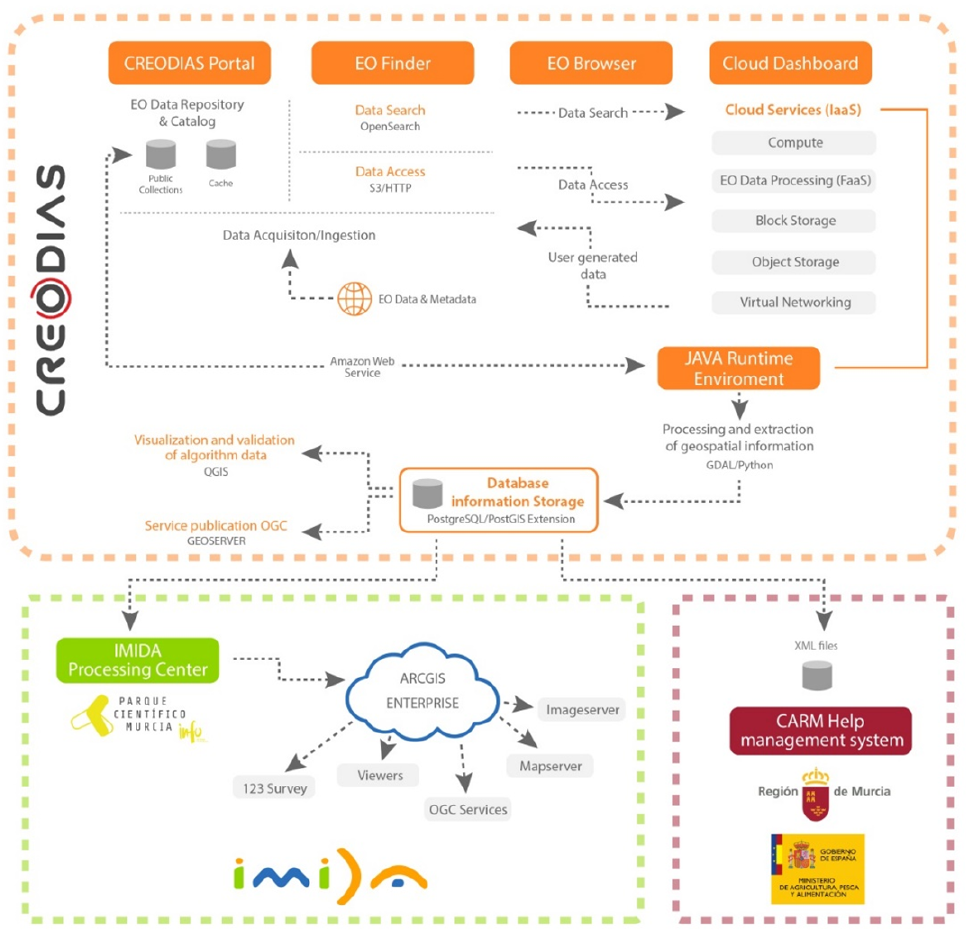
Figure 3. The geospatial infrastructure design used in this